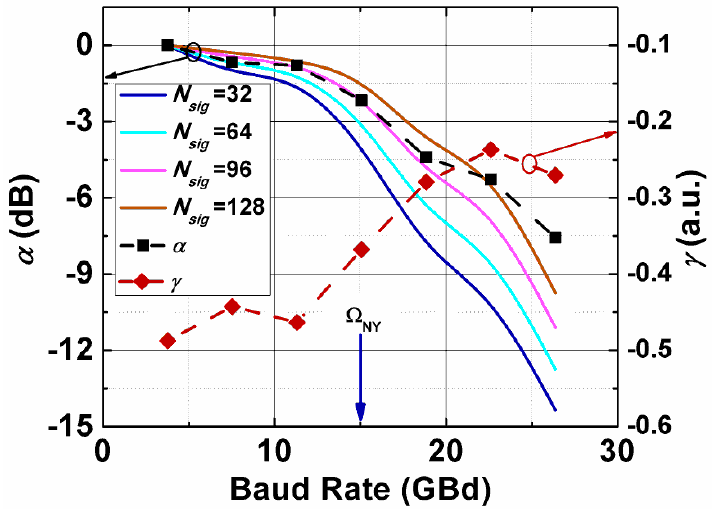
Figure 4. Bandwidth and nonlinearity of one tributary. Bandwidth is plotted on the left axis and nonlinearity is plotted on the right axis.